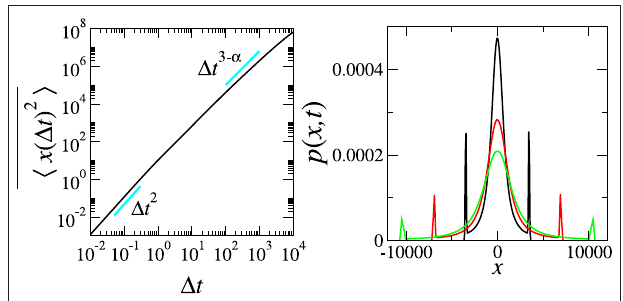
FIGURE 8 | MSD (Left) and p ( x , t ) (Right) of the overdamped Langevin model Equation 27 for the two-state model of f i ( 1). The p ( x , t ) are plotted at t = = ± 8,000 (black), 9,000 (red), and 10,000 (green). For the duration time, the power-law PDF with α 1.2 was used. The simulation details were same as in = Figure 5 . The data were obtained from 10 5 simulation runs. The basic units D / D / √ σ , [ t ] σ are: [ x ] ˜ = ˜ =